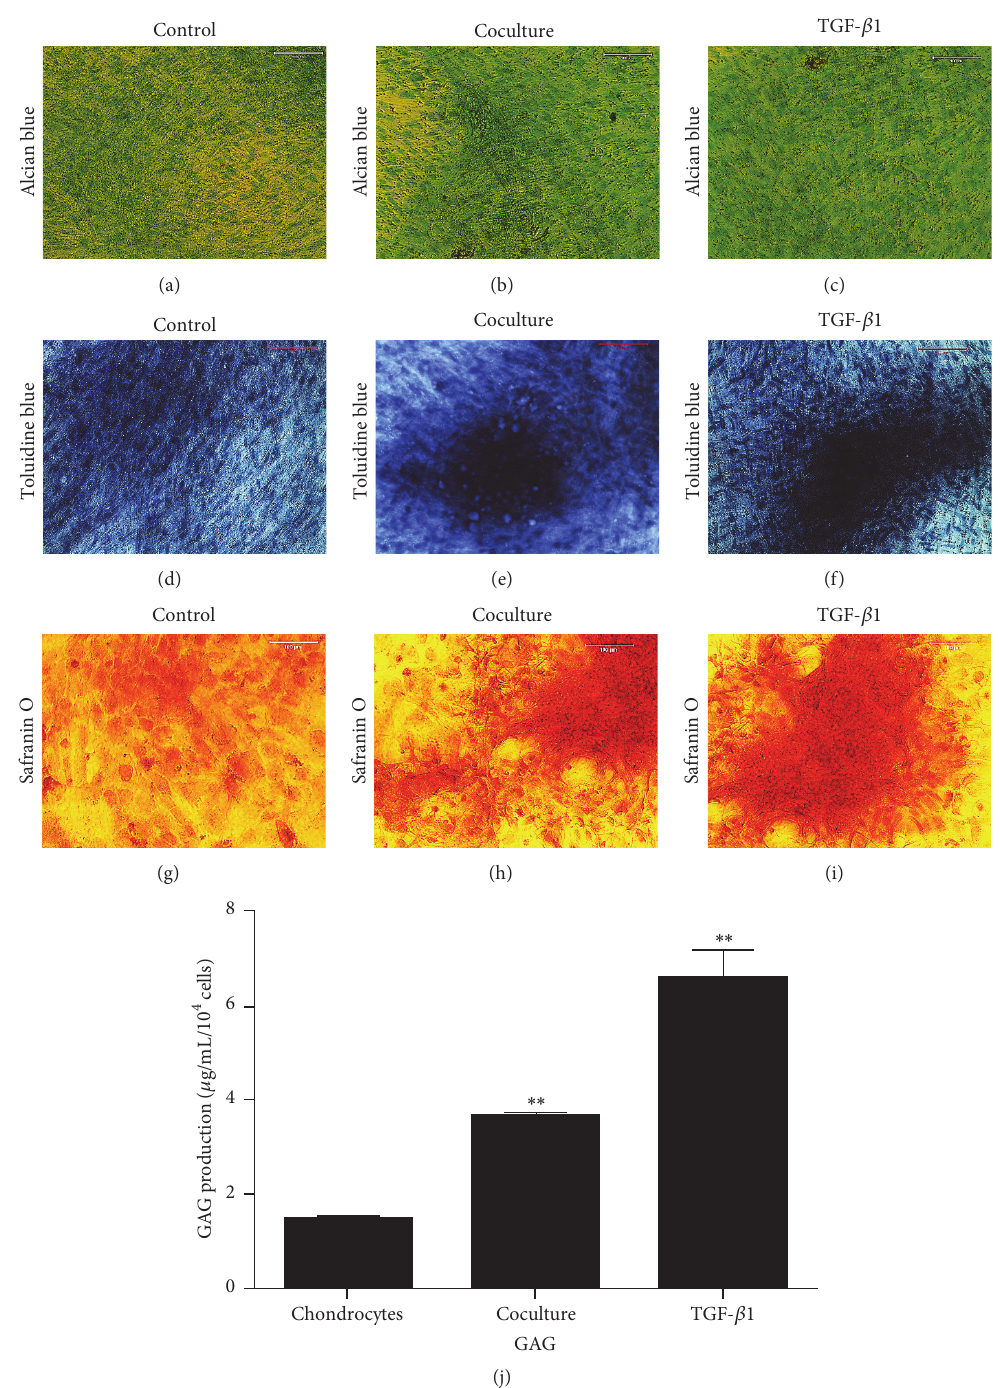
Figure 5: Chondrogenesis marker expression in chondrocytes cultured with three different conditions for 9 days detected by histochemical staining ((a)–(i)) and ELISA (j). Alcian blue staining is shown in ((a)–(c)). Toluidine blue staining is shown in ((d)–(f)). Safranin O staining is shown in ((g)–(i)). Chondrocytes were cultured in control medium ((a), (d), and (g)), or ADSCs cocultured system ((b), (e), and (h)), or TGF- 𝛽 1-containing medium ((c), (f), and (i)) and stained by the above three markers. The production of glycosaminoglycan (GAG) was analyzed using ELISA kit (j). Data are shown as mean ± SEM. ∗∗ 𝑝 < 0.01 versus control group. Control: chondrocytes were cultured in normal culture medium. Coculture: chondrocytes were cocultured with ADSCs together. TGF- 𝛽 1: chondrocytes were cultured with TGF- 𝛽 1- containing